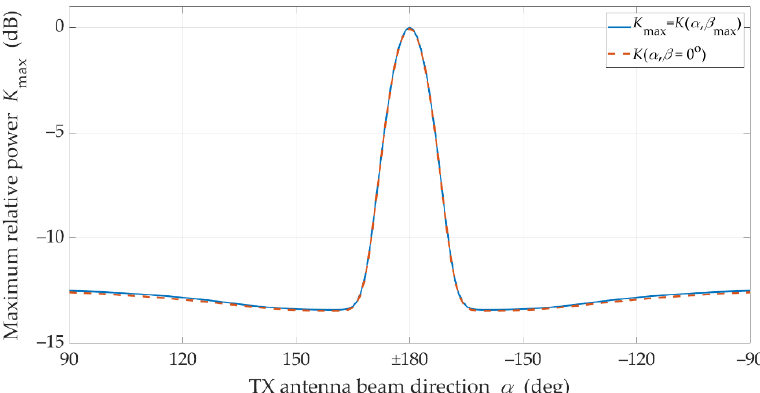
Figure 4. Received signal power losses due to mismatch of transmitting beam direction under LOS conditions.